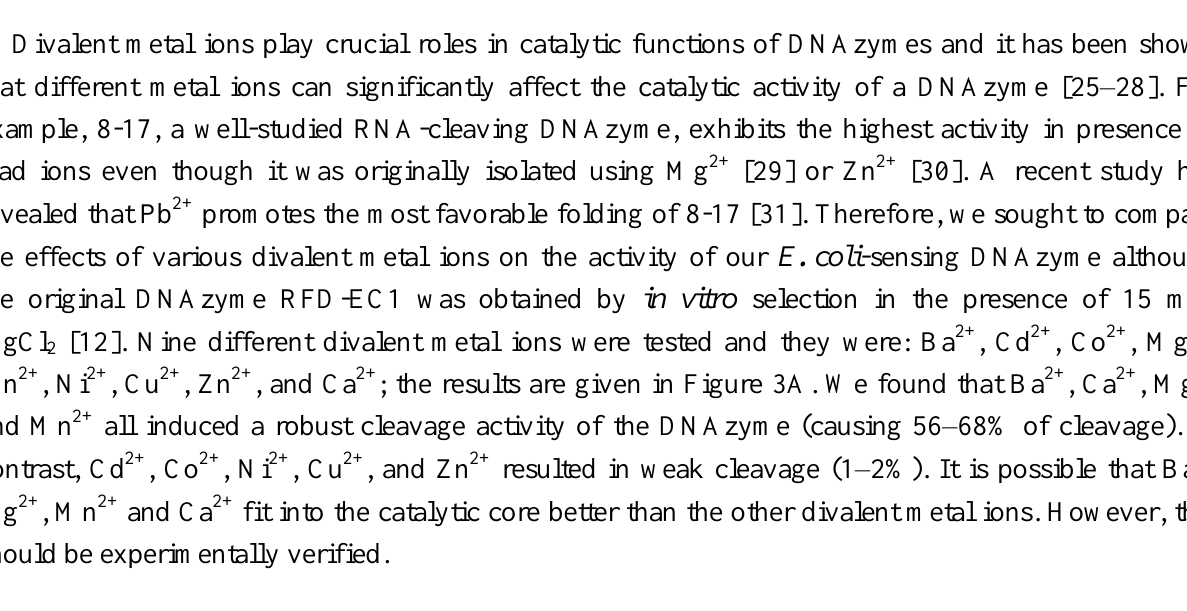
Figure 3. ( A ) Cleavage activity of EC1T/FS1 in the presence of CEM-EC and various divalent metal ions. ( B ) Effect of the Ba 2+